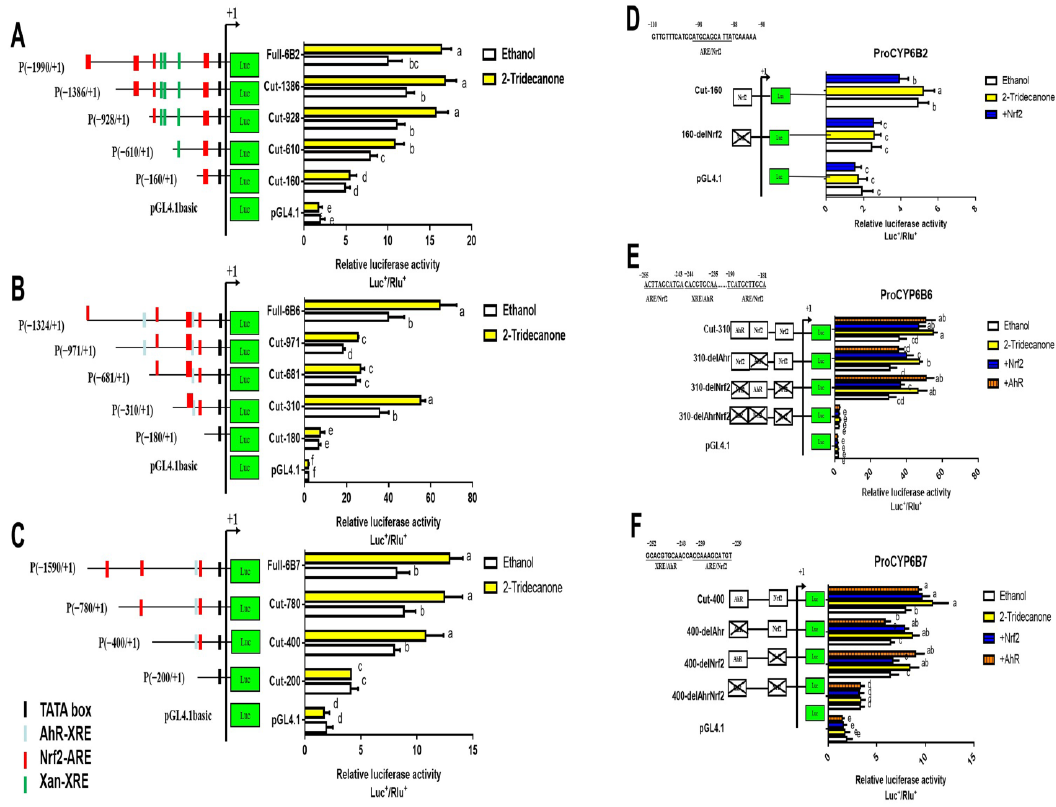
Figure 5. The promoter activity of CYP6B2 ( A ), CYP6B6 ( B ) and CYP6B7 ( C ) induced by 2-tridecanone and the deletion of XRE/AhR or ARE/Nrf2 elements affects 2-tridecanone-induced CYP6B2 ( D ), CYP6B6 ( E ) and CYP6B7 ( F ) promoter activity. Element position “+1” is defined relative to the start codon ATG. Different letters on error bars show significant differences ( p <